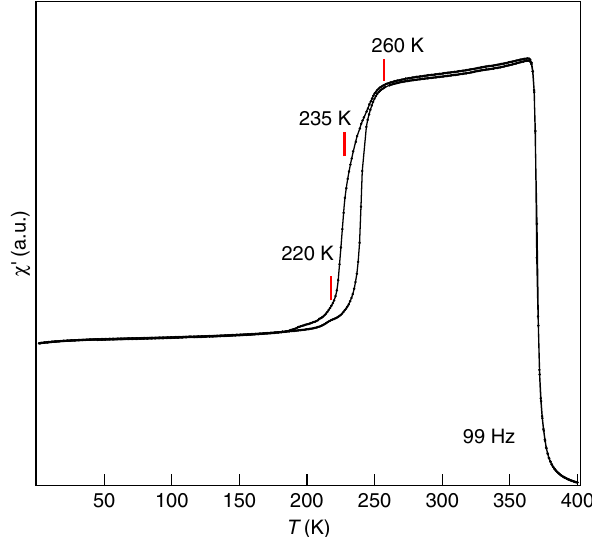
Fig. 1 Temperature-dependent ac-susceptibility. Real part of ac- χ as a function of temperature in cooling and heating cycles. Red ticks indicate the temperatures that correspond to the different phases observed in synchrotron X-ray powder diffraction (see